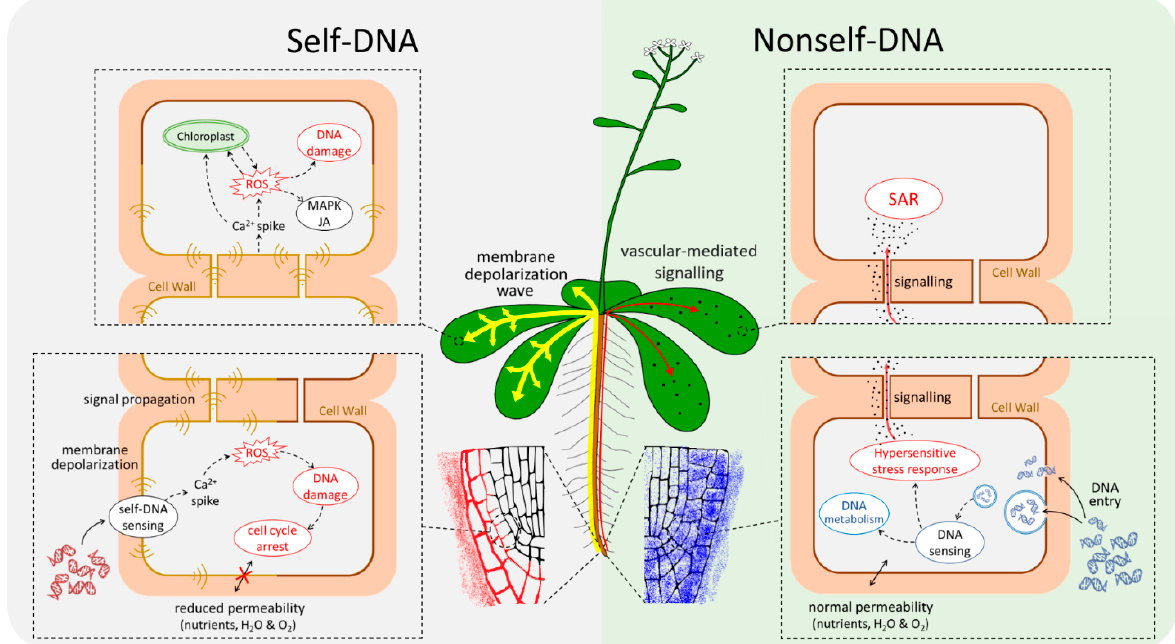
Figure 7. Model of Extracellular DNA Associated Pathways (EDAP) in plants. The exposure to either self- or nonself-DNA produces differential cellular responses. The self-DNA treatment triggers an electric response, starting with a sensing at membrane level, with calcium spikes followed by a reduced permeability of the roots, and a cascade of events involving the chloroplasts and inducing ROS production. On the other hand, nonself-DNA enters the cells where it is metabolized activating a cascade of events inducing a hypersensitive response.